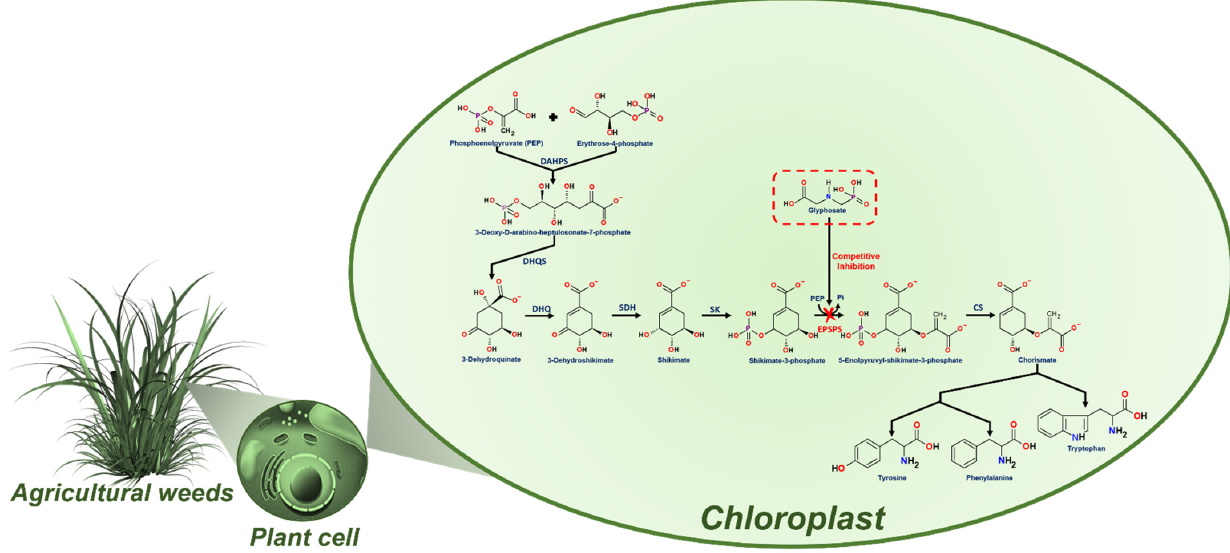
Figure 1. Glyphosate action mechanism through the inhibition of the shikimate pathway. Enzymes implicated in the pathway, DAHPS: 3-Deoxy-D-arabino-heptulosonate-7-phosphate synthase; DHQS: 3-Dehydroquinate synthase; DHQ: 3-Dehydroshikimate dehydratase; SDH: shikimate-5-dehydrogenase; SK: shikimate kinase; EPSPS: 5-Enolpyruvyl shikimate 3-phosphate synthase; and CS: chorismate synthase.